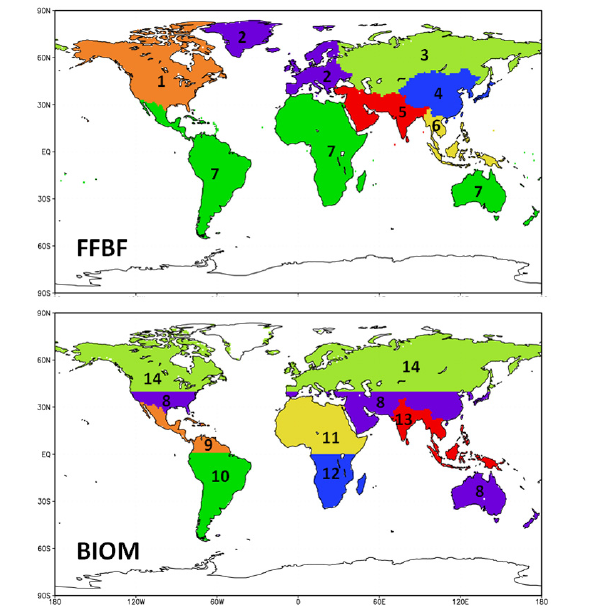
Fig. 2. Color-coded definition of fossil-fuel (FFBF) and biomass burning (BIOM) CO source regions (after Arellano et al., 2004). Numbers represent the source category number used in the text: 1 = FFBF North America (FFBF-NAM); 2 = FFBF Europe (FFBF- EUR); 3 = FFBF Russia (FFBF-RUS); 4 = FFBF East Asia (FFBF- EAS); 5 = FFBF South Asia (FFBF-SAS); 6 = FFBF Southeast Asia (FFBF-SEA); 7 = FFBF Rest of the World (FFBF-ROW); 8 = BIOM Other (BIOM-OTH); 9 = BIOM Northern Latin Amer- ica (BIOM-NLA); 10 = BIOM Southern Latin America (BIOM- SLA); 11 = BIOM Northern Africa (BIOM-NAF); 12 = BIOM Southern Africa (BIOM-SAF); 13 = BIOM South and Southeast Asia (BIOM-SSA); 14 = BIOM Boreal (BIOM-BOR). Source cat- egory 15 (not shown here) represents the global source of CO from biogenic hydrocarbon oxidation